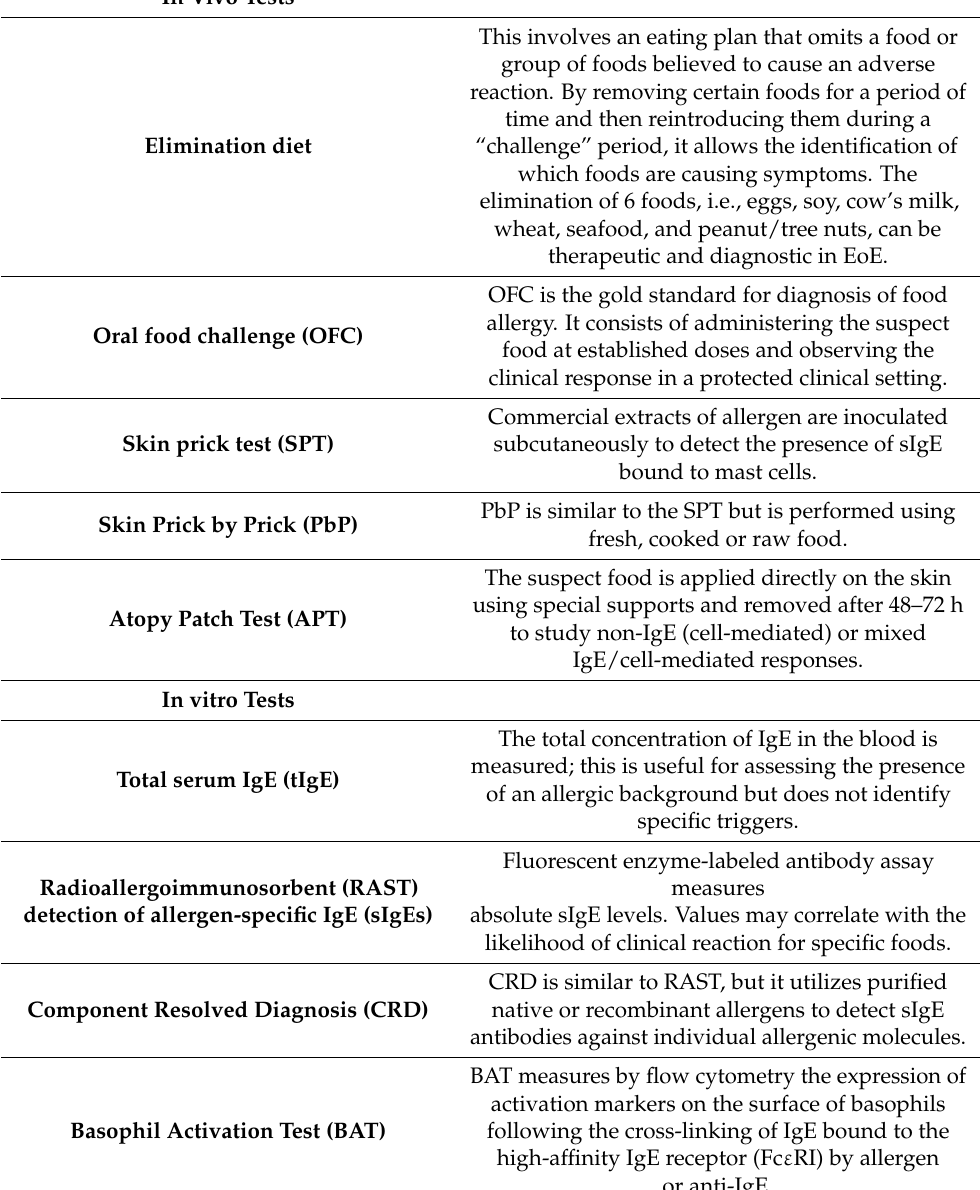
Table 3. In vivo and in vitro tests for the diagnosis of IgE-mediated food allergies